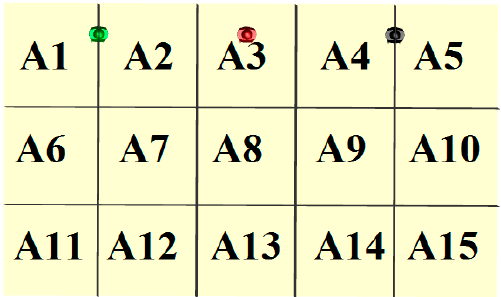
Figure 3. Top view of the indoor space.